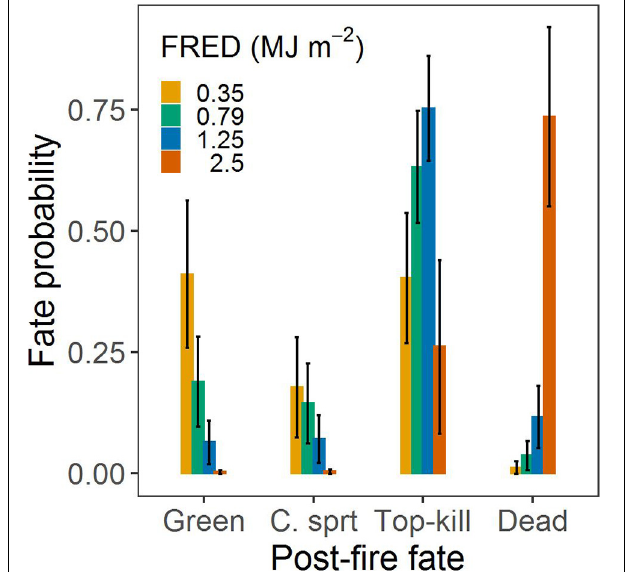
FIGURE 2 | Predicted probability (narrow vertical lines indicate 95% confidence limits) of four possible fates of shrub-form hardwood trees at five levels of FRED that span a range of fire intensity from experimental prescribed fires in longleaf pine woodlands in southwest Georgia, United States. Probabilities are averaged over all guilds, and probabilities of each fate at each level of FRED sum to 1. Post-fire fates are “Green,” functional green leaves remaining in crown; “C. sprt,” complete scorch with new sprouts from the crown; “Top-kill,” complete scorch with new sprouts from the base; “Dead,” complete scorch with no new